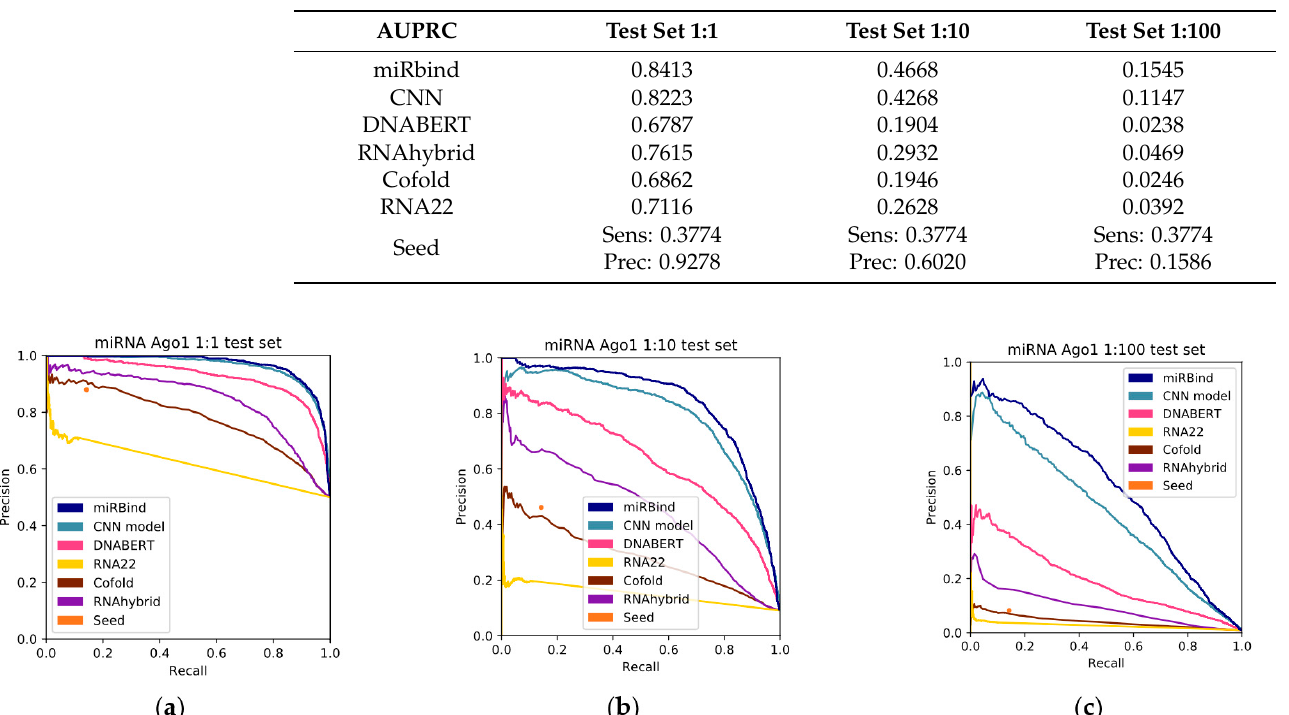
Table 3. Area under the receiver operator characteristics curve (AUROC) for the miRBind, CNN, and DNABERT models, as well as the RNAhybrid, ‘cofold’, RNA22, and ‘seed’ approaches, tested against 1:1, 1:10, and 1:100 left-out test sets. The ‘seed’ method is evaluated based on the false positive rate (fpr) and true positive rate (tpr). Table 4. The area under the precision-recall curve (AUPRC) for miRBind, CNN, and DNABERT models, as well as RNAhybrid, ‘cofold’, RNA22, and ‘seed’ approaches, tested against the 1:1, 1:10, and 1:100 Ago eCLIP test sets.